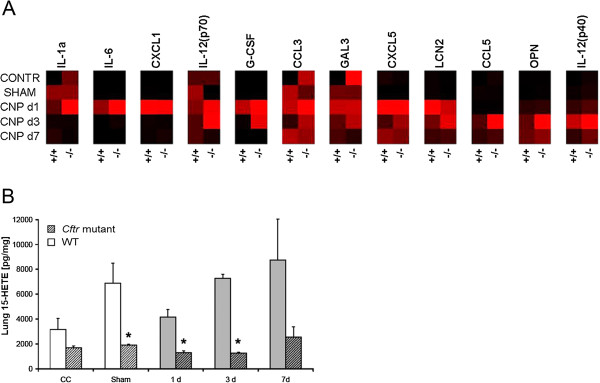
BAL cytokines and lipid mediators after CNP instillation. A) Heat map of cytokines. Black boxes indicate lowest and bright red highest detected levels for each cytokine (according to Table 3). Cytokines have been sorted by the response pattern. IL-1a, IL-6, and CXCL1 showed highest levels at day 1 after CNP exposure, CCL5, OPN, and IL-12p40 at day 3. Overall elevated cytokine levels were observed in Cftr mutant (−/−) as compared to WT (+/+) mice. B) 15-HETE. Increase over time after instillation treatment in WT mice, but independently of the CNP exposure; 15-HETE was generally reduced in Cftr mutant mice (hatched bars). *: significant difference to WT animals, p < 0.05. CC: cage control (untreated animals); Sham: instillation of 50 μL pyrogene-free distilled water.